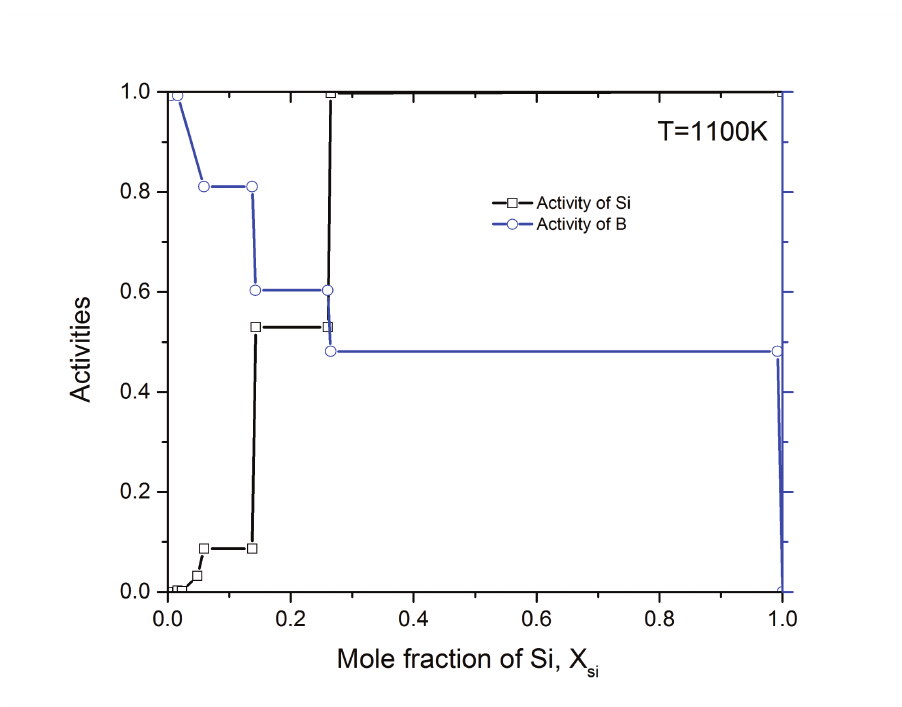
Figure 4: Activity of B and Si in a liquid Si melt at 1100 K.